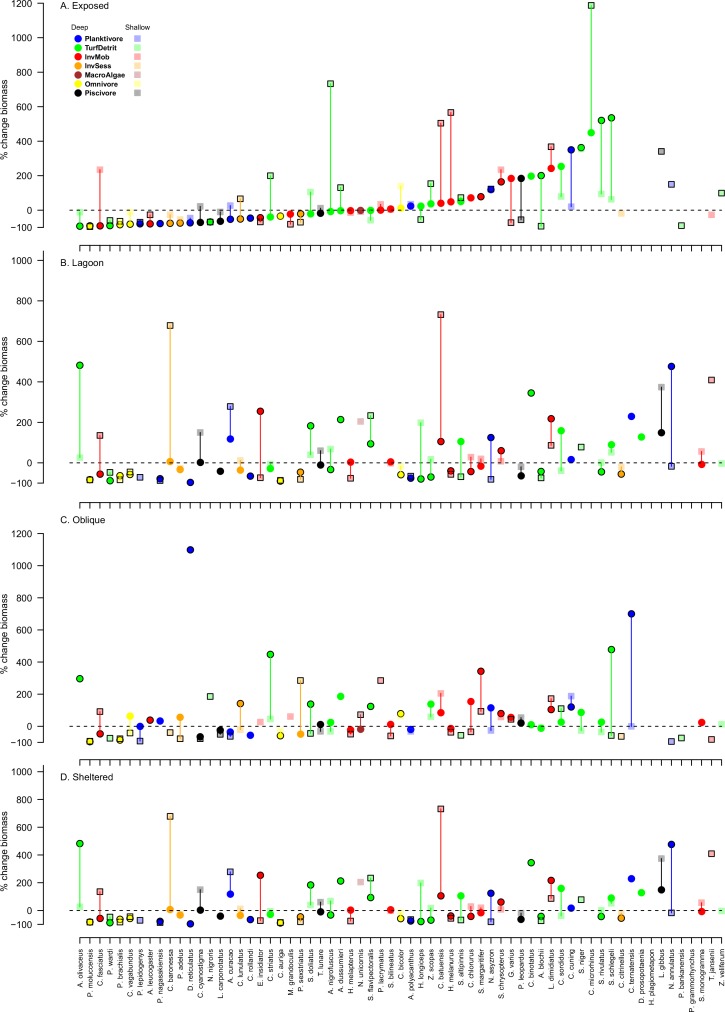
Average percentage change in the biomass of individual fish species between 2011 and 2015 for A. exposed, B. lagoon, C. oblique and D. sheltered sites of Lizard Island. Fish species were only included in analyses if there were at least 10 individuals in both years. The y axis is the percent change in biomass. Colours represent trophic affiliations: blue = planktivores, orange = sessile invertebrate feeders, white = omnivores (feeding on both plant and animal matter), green = turf and detritus feeders, red = mobile invertebrate feeders, black = piscivores and dark red = macroalgal feeders. Symbols with black outlined represent species for which biomass changed significantly at that depth-exposure combination. Vertical lines link deep and shallow symbols for each species and are for ease of observation.